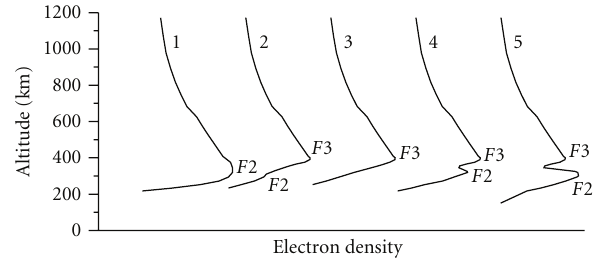
Figure 21: Sketch of diurnal variations of the electron density pro- file near the geomagnetic equator: (1) the daytime electron density profile with a one-layered pattern without F2 layer stratifications. (2) the sunset electron density profile with a two-layered pattern— the F3 layer appears due to the non-uniform in height vertical plasma drift and the F2 layer disappears due to the reduction of photoionization, at that foF3 > foF2 . (3) he nighttime electron density profile with a one-layered pattern—the F3 layer occurs, the F2 layer almost disappears. (4) the morning-noon electron density profile with a two-layered pattern—the F2 layer appears due to the increase of photoionization and the F3 layer continues to occur (this could also appear in the sunset local time). (5) the afternoon electron density profile with a two-layered pattern—the foF2 continue increases due to the photoionization processes, at that foF3 becomes smaller than foF2 . Further the F3 layer merges with F2 layer, and the electron density profile turns type